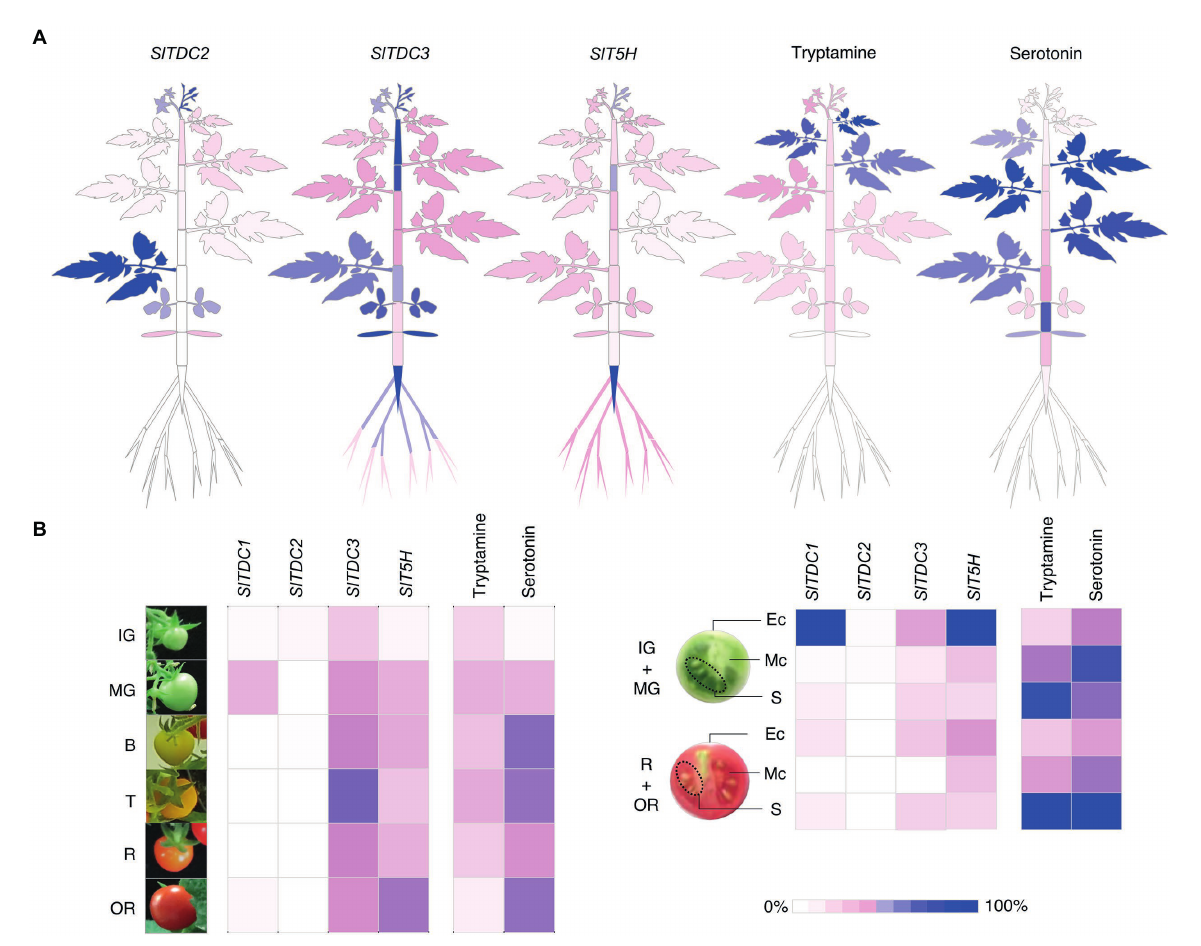
FIGURE 8 Heat maps representing the percentage relative expression of SlTDCs and SlT5H genes and the accumulation of tryptamine and serotonin in Micro-Tom plants (A) and fruits (B) . Expression levels are shown as percentages relative to the organ with the highest expression (100%). Each organ and stage/tissue identified in this heat map refers to the sampling design in Figure